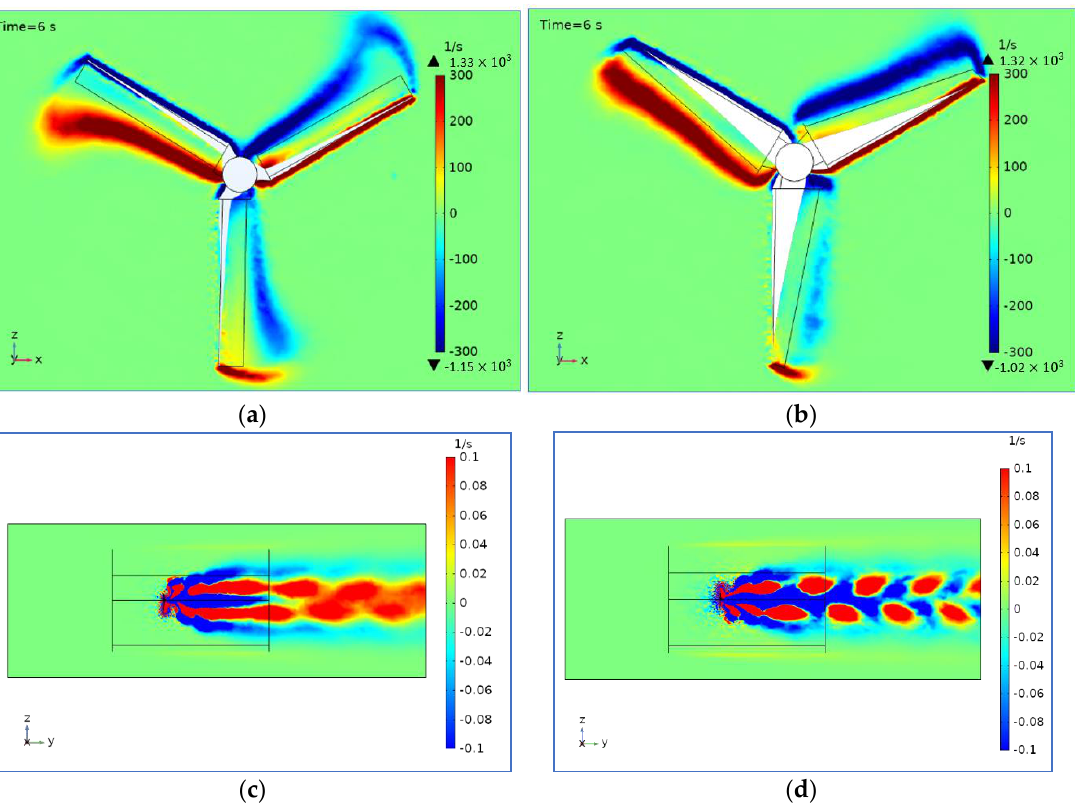
Figure 9. x-z view of the vorticity profile for the ( a ) rectangular and ( b ) tapered configurations (NACA4412 airfoil), and z-y view of the vorticity profile for the ( c ) rectangular and ( d ) tapered configurations.